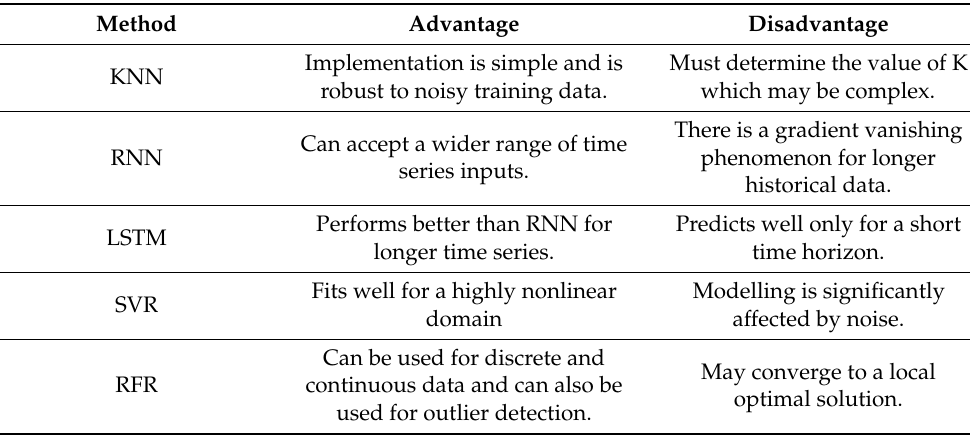
Table 1. Comparison of the five single models. Method Advantage Disadvantage Implementation is simple and is KNN robust to noisy training data. Can accept a wider range of time RNN series inputs. Performs better than RNN for LSTM longer time series. Fits well for a highly nonlinear SVR domain Can be used for discrete and RFR continuous data and can also be used for outlier detection.